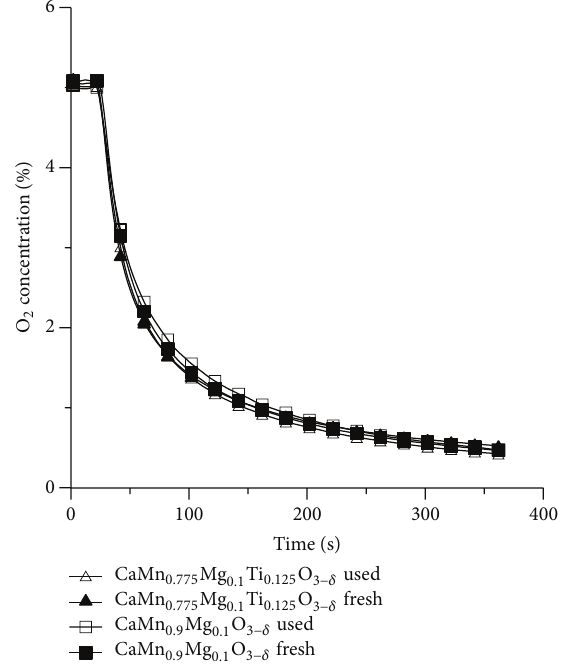
Figure 9: Outgoing oxygen concentration during batch experi- ments. The fluidizing gas is changed from 5% oxygen in nitrogen to 100% nitrogen at time 0. The 20 s delay is the time it takes for gas to reach gas analyzer. Fresh particles are compared to particles which have been used in the 300 W